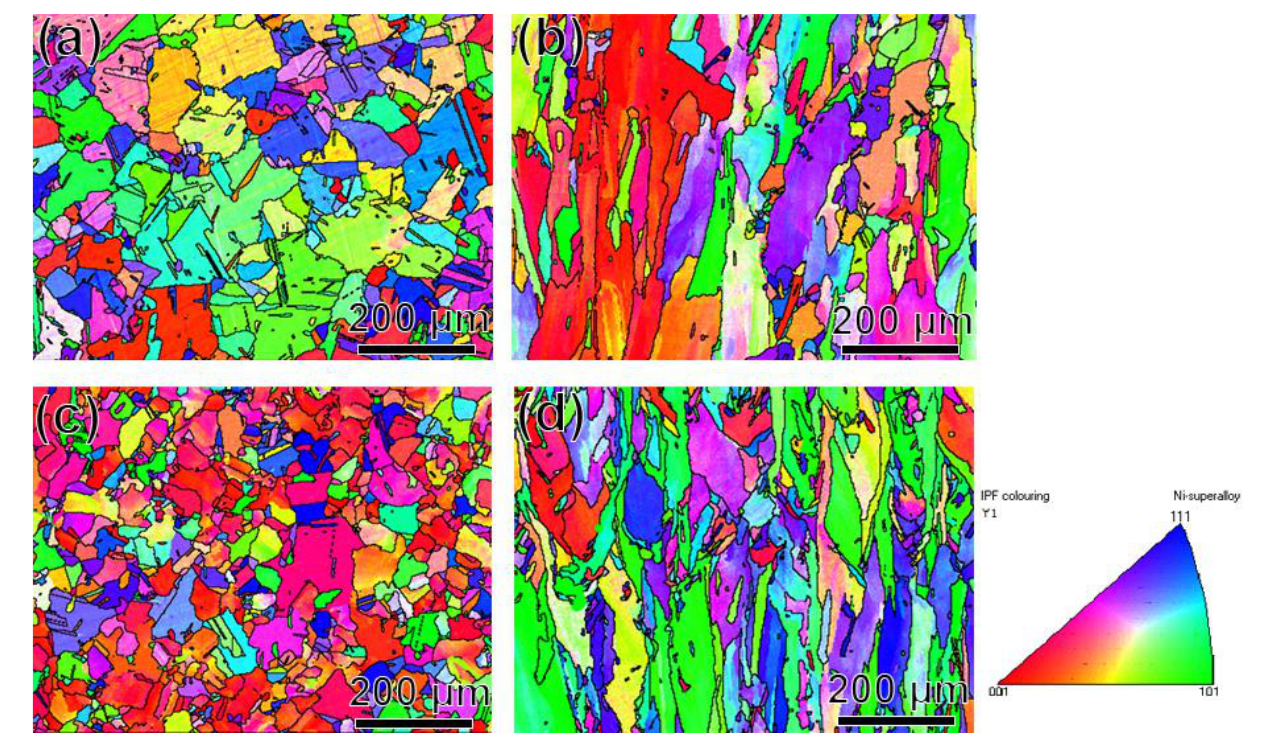
Figure 3. The IPF of the SLM processed Haynes 230 and CRHA. ( a ) was the vertical view of Haynes 230, ( b ) was the horizontal view of Haynes 230, ( c ) was the vertical view of the CRHA, ( d ) was the horizontal view of the CRHA.